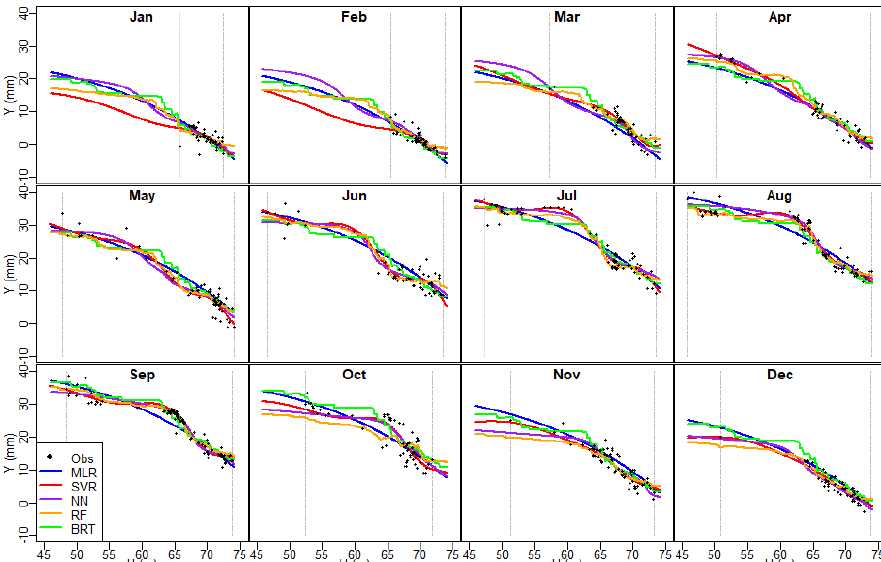
Figure 16. Sensitivity analysis due to the hydrostatic effect for Machine Learning model results based on the training data. The vertical lines are the maximum and minimum measured values obtained during the training